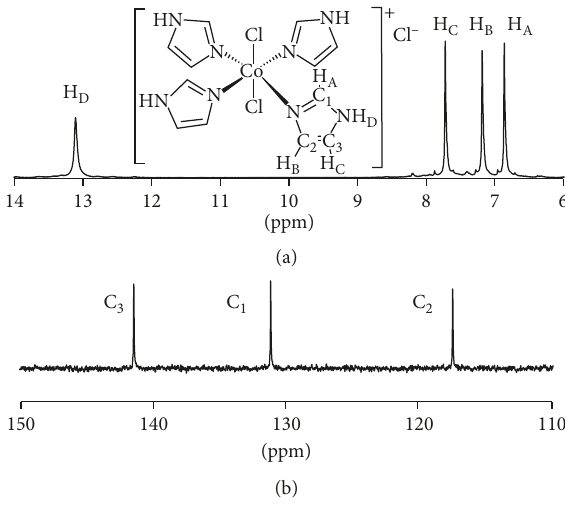
6 Figure 3: UV-Vis absorption spectra of 2mM of 2 in H time � 0 (black) and time � 36 hours (red). Immediately after the addition of 10 equivalents of the biological reducing agent, ascorbic acid (blue), the signature Co(III) d - d transitions decrease in in- tensity over time (after 36 hours is shown in green) suggesting that reduction of the cobalt center is observed.